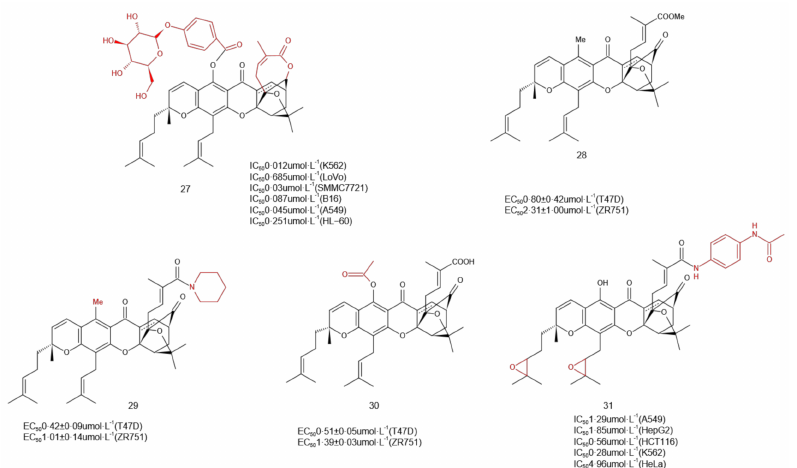
Figure 7. Diversity of modification sites.